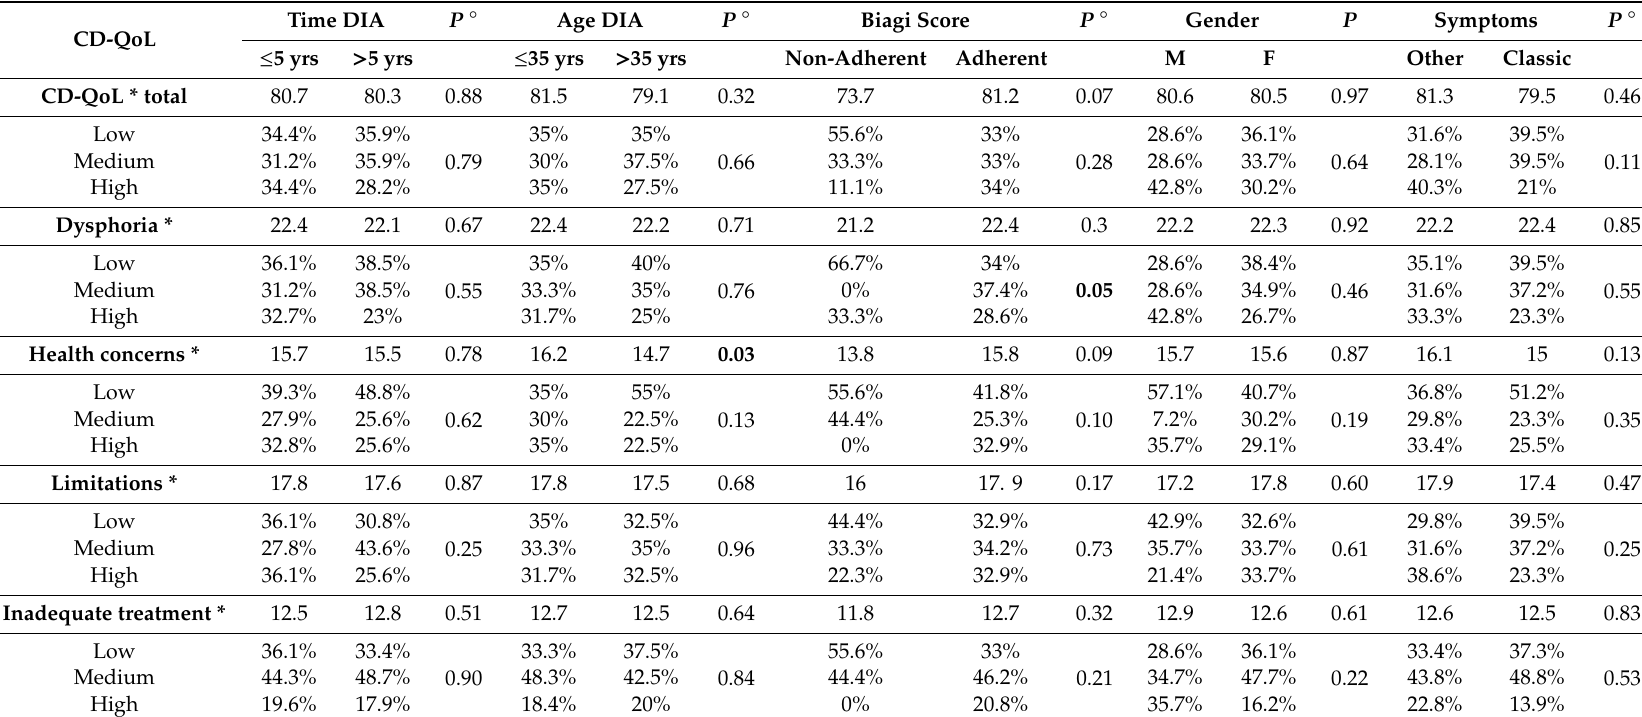
Table 2. CD-QoL scores stratified by time of diagnosis, age at diagnosis, Biagi score, gender and